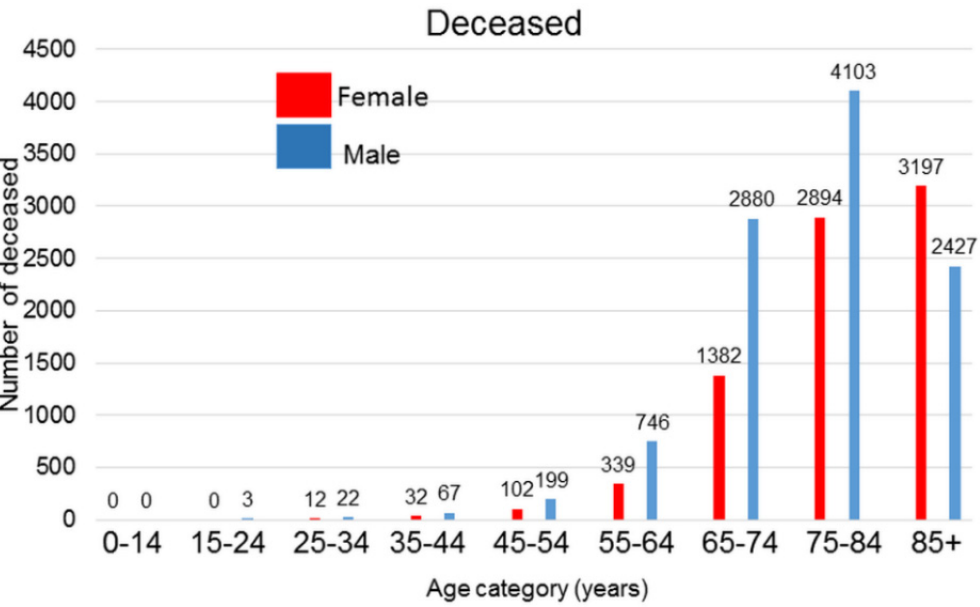
Figure 2. Number of deaths in the Czech Republic until mid–February 2021 according to the data published by the Ministry of Health of the Czech Republic.